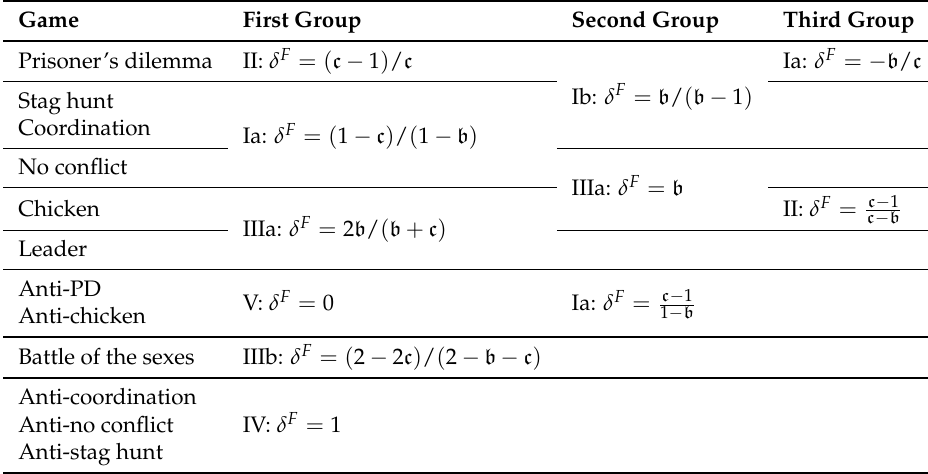
Table 2. The values of discount factor δ F with public correlation.